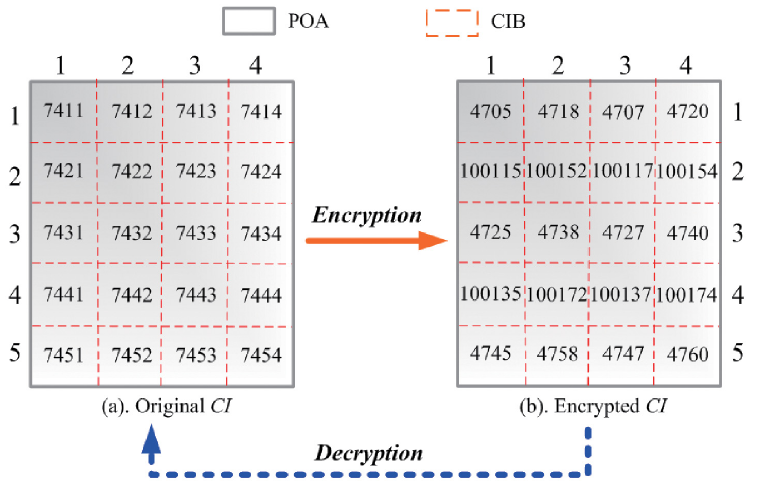
Fig 4. Comparison of the ID numbers of the CIB s before and after